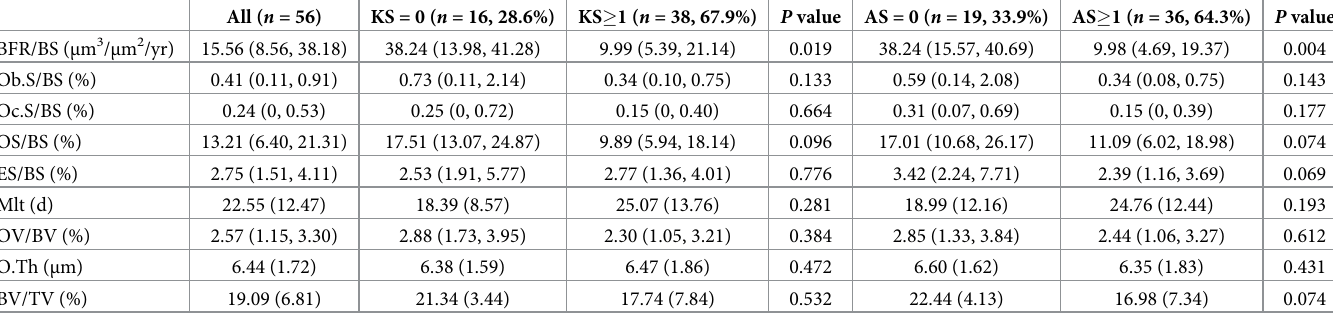
Table 3. Bone histomorphometric parameters according to vascular calcification